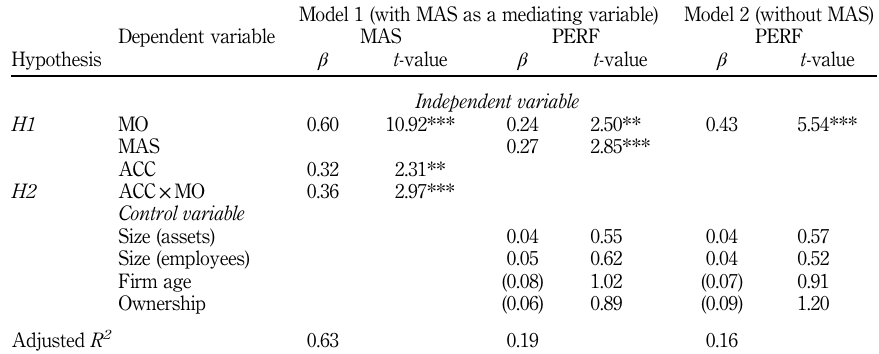
results for theoretical